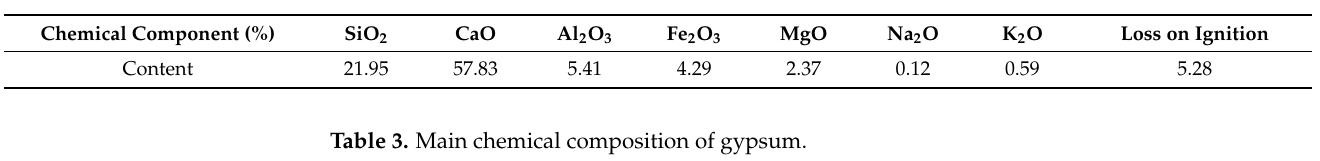
Table 2. Main chemical composition of cement.